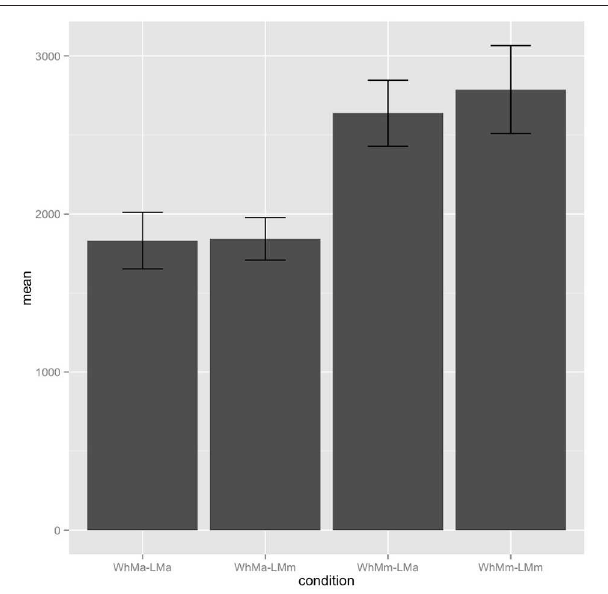
FIGURE 2 | Experiment 2 spillover region regression path